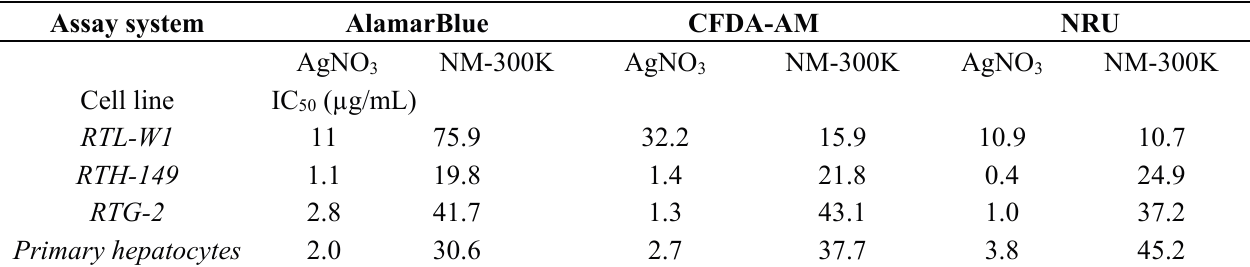
Figure 1. Cytotoxicity of AgNO 3 and AgNPs NM-300K according to AlamarBlue assay. ( a ) Cytotoxicity measured using the AlamarBlue assay and metabolic activity as endpoint of toxicity in liver cell lines (RTL-W1 and RTH-149), a gonadal cell line (RTG-2) and primary hepatocytes from rainbow trout following 24 h exposure to AgNO 3 ; ( b ) silver nanomaterial NM-300K. Cells exposed to concentration 0 received the maximal concentration of the dispersant and served as control. Values represent the mean ± standard error of the mean (SEM) (n = 3); * denotes statistically significant differences from control ( p < 0.05). Table 2. IC50 (µg /mL) values calculated from the different cytotoxicity assay systems in the rainbow trout cell lines and primary hepatocytes after exposure to AgNO 3 and